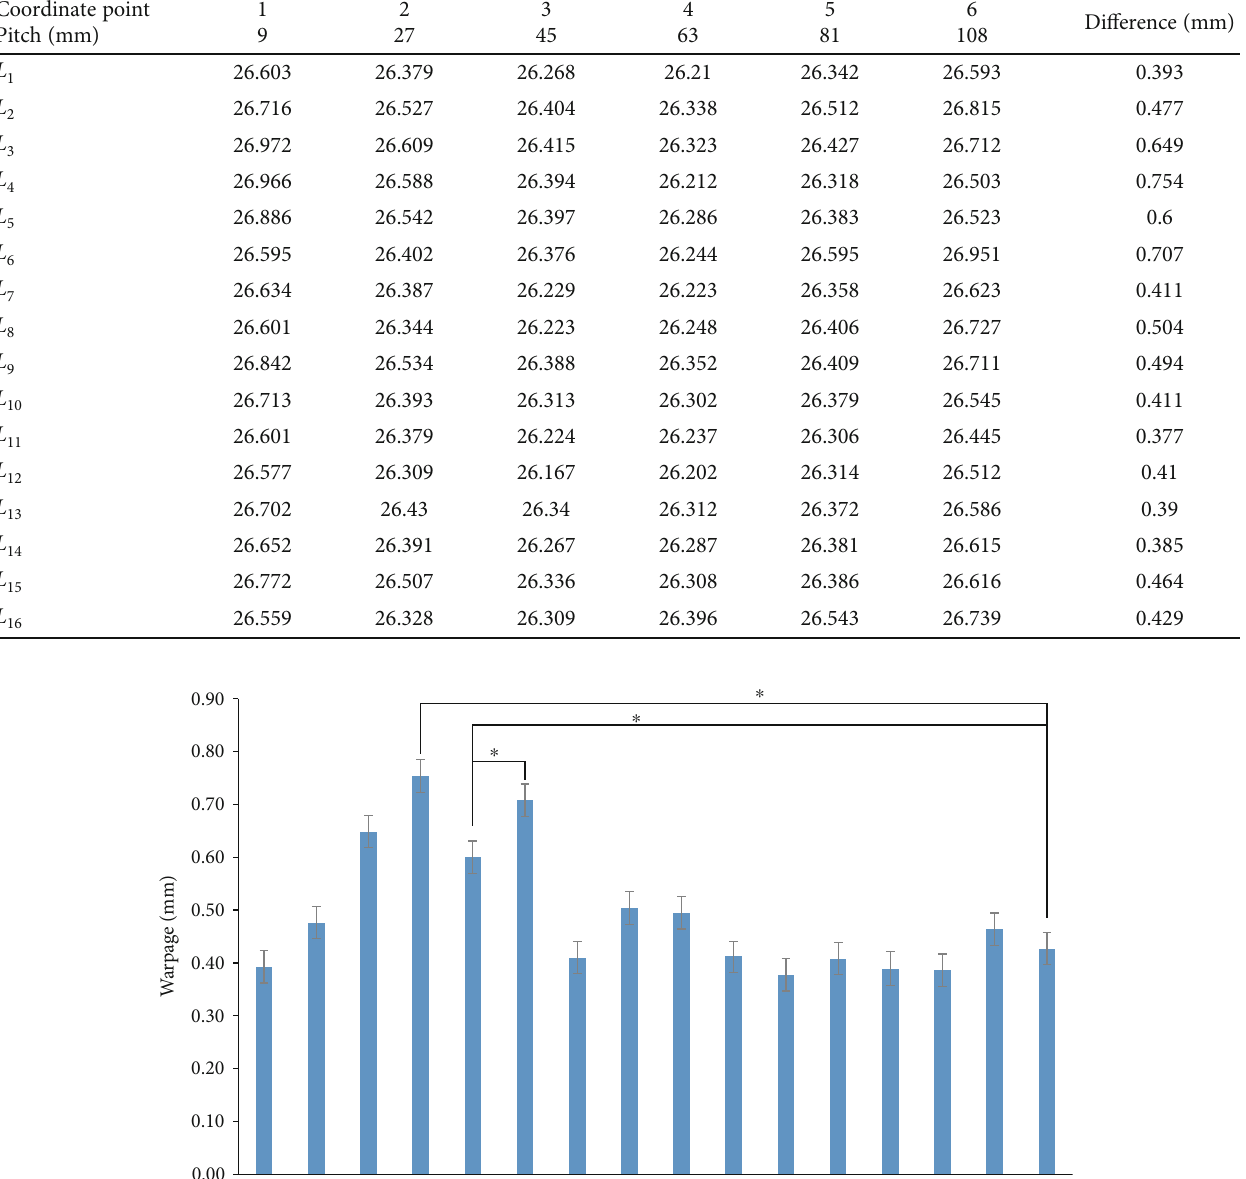
Table 5: Warpage of the thin-walled part in the experiment (using thin-wall injection molding). Coordinate point